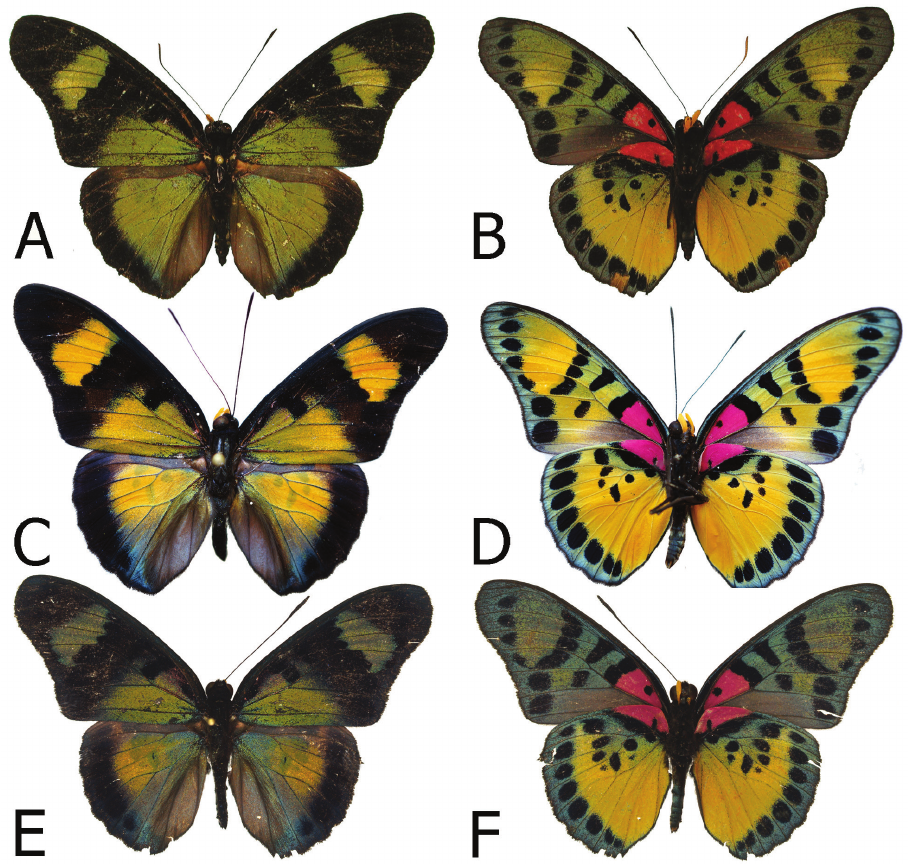
Figure 6. Adults, males: A E. sarcoptera cyparissoides holotype (dorsum) B E. sarcoptera cyparissoides holotype (venter) C E. sarcoptera nipponicorum Mbandaka, Congo (dorsum) D E. sarcoptera nipponico- rum Mbandaka, Congo (venter) e E. sarcoptera sarcoptera-styx cline, Mount Swa, Liberia (dorsum) F E. sarcoptera sarcoptera-styx cline, Mount Swa, Liberia pine green and black. Male genitalia (Fig. 11E): Tegumen same length as uncus, with a flat dorsal surface; uncus stout, slightly arched, with a sharp tip pointing downwards, tegument and uncus approximately the same length as in the nominate subspecies; gnathos long, same length as uncus; pedunculus prominent; saccus flattened in lateral view; valvae with a smooth dorsal surface with an elongated distal extremity ending with a sharp tip, differing in this respect from the blunt valvae of the nominate subspe- cies and styx ; aedeagus as long as valvae tubular and straight, with a sharp distal extrem- ity, sensibly longer than in the nominate subspecies or styx , and prominent cornuti. Female (Figs 7C, 7D): Head, thorax and abdomen abdomen same as in the nomi- notypical subspecies. Wings: FW (length 42-46 mm, n=3) with an elongated apical part, and gently convex outer margin; most of wing surface black; costa from base to